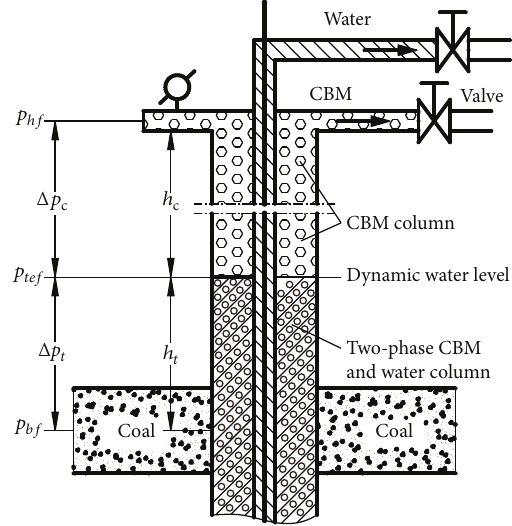
Figure 1: The components of fl owing pressures and pressure drops in two-phase CBM